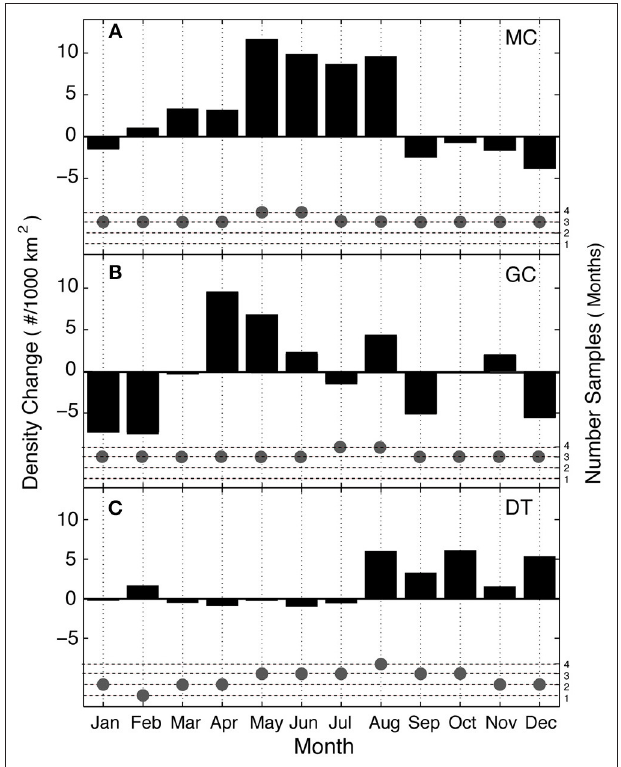
FIGURE 10 | Seasonal patterns of Kogia spp. density (black bars), shown as monthly adjustments at sites MC (A) , GC (B) , and DT (C) . Number of months with data (gray dots) for each